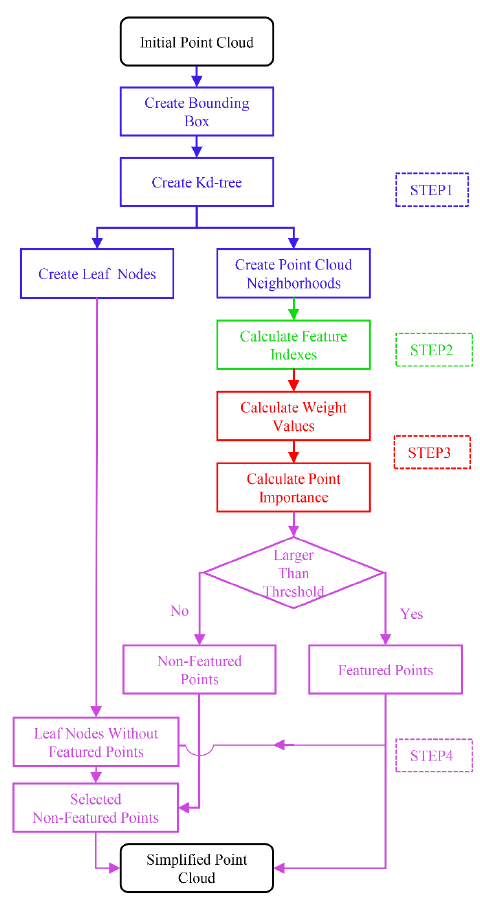
Figure 1. Flow chart of the MIWSA.